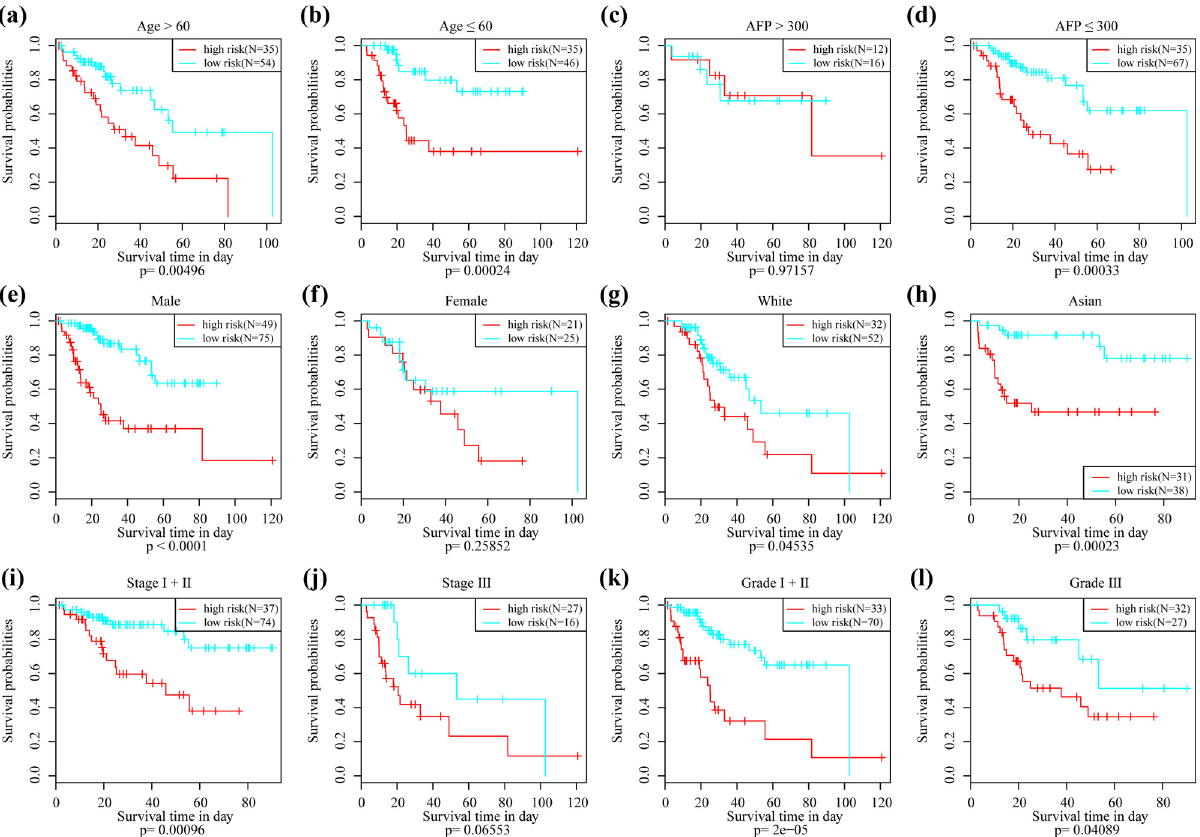
Figure 6: KM curve analysis of 4 - mRNA signature in clinical features: ( a ) prognostic KM curve in elderly samples ( age > 60 ) , ( b ) prognostic KM curve in young samples ( age ≤ 60 ) , ( c ) prognostic KM curve in serum AFP greater than 300 samples, ( d ) prognostic KM curve in serum AFP < 300 samples, ( e ) prognostic KM curve in the male sample, ( f ) prognostic KM curve in the female sample, ( g ) prognostic KM curve in Caucasian samples, ( h ) prognostic KM curve in Asian samples, ( i ) prognostic KM curve in Stage I + Phase II samples, ( j ) prognostic KM curve in Stage III samples, ( k ) prognostic KM curve in Grade I + II samples, and ( l ) prognostic KM curve in Grade III